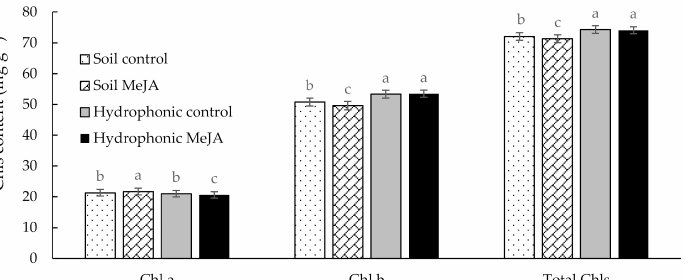
Figure 2. Chlorophyll (Chl) a, Chl b, and total Chl contents of pak choi grown in soil or hydroponics with or without the treatment of methyl jasmonate (MeJA). Different letters on the bars indicate a significant difference ( p < 0.05) between the treatments. The vertical bars represent the standard error of the mean ( n =